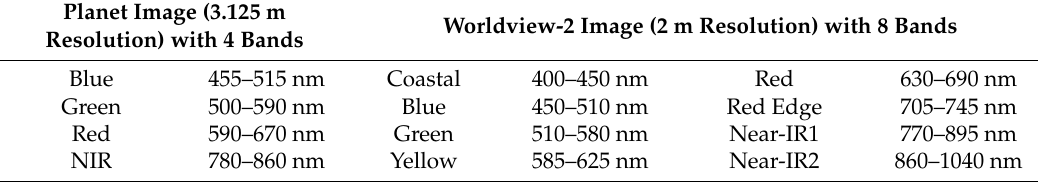
Table 4. Band specifications of Planet and Worldview